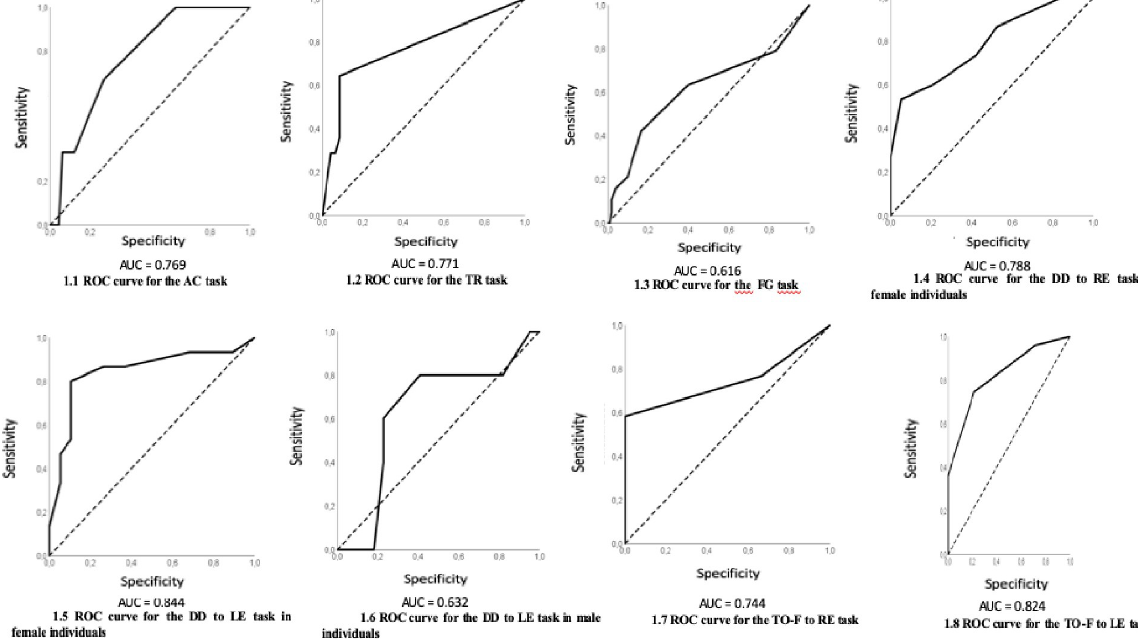
Fig 1. ROC curves for the auditory tasks of schoolchildren in the between 6- to 7-year-old age group.